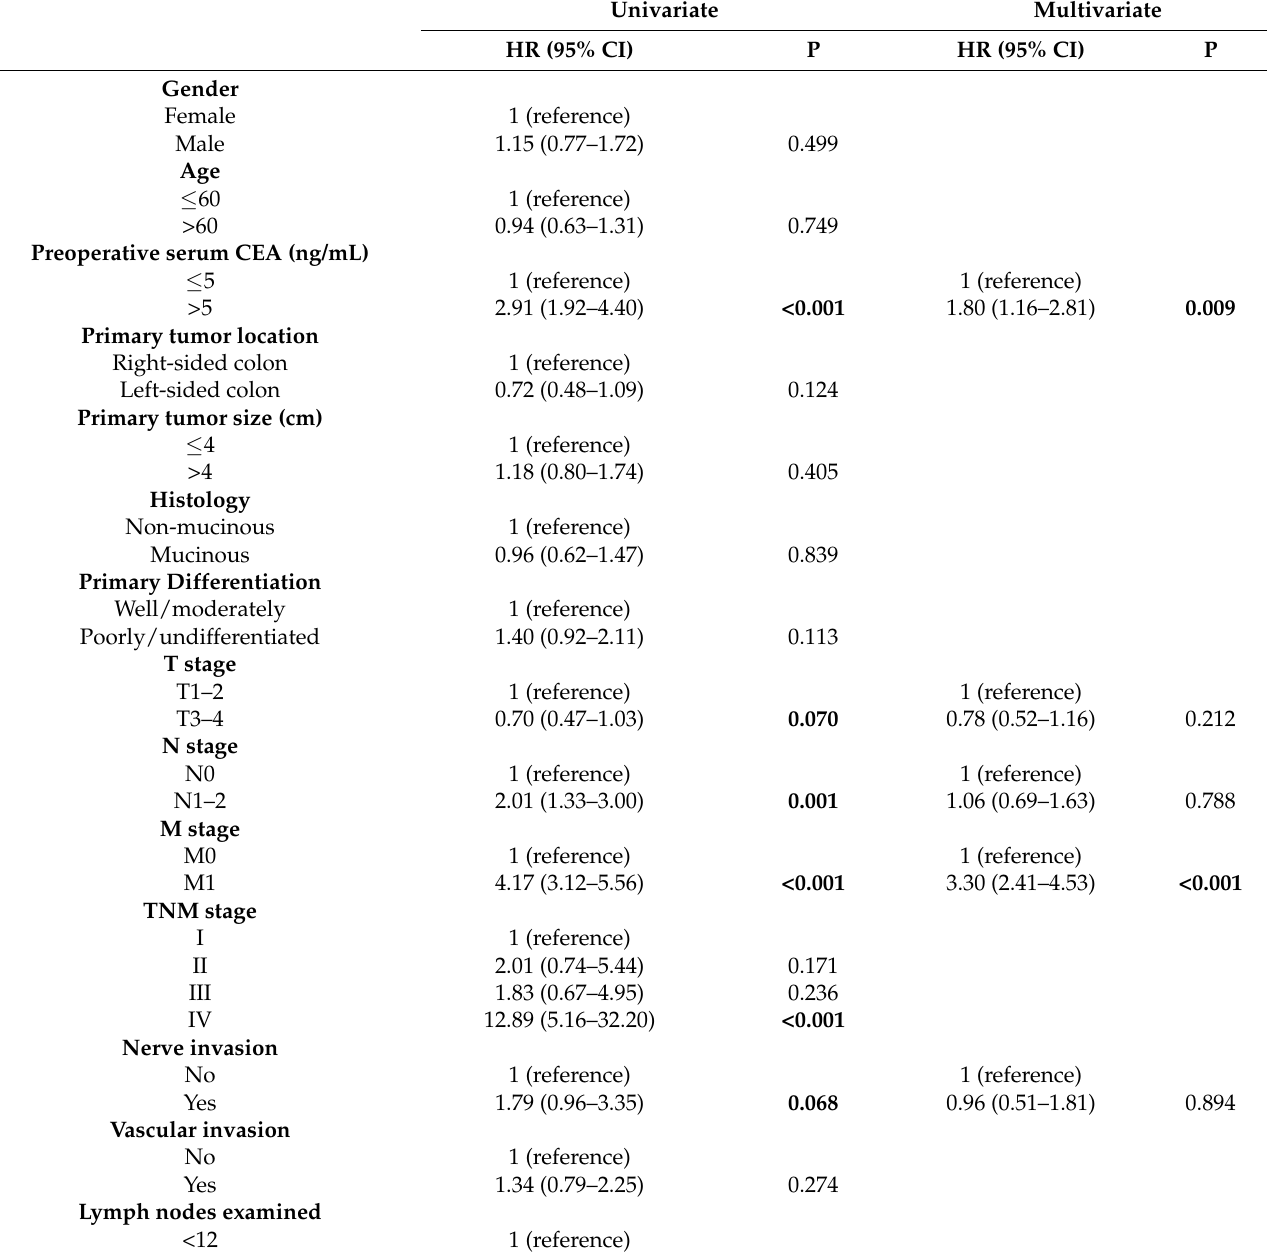
Table 2. Cox regression analysis for OS of primary cohort.